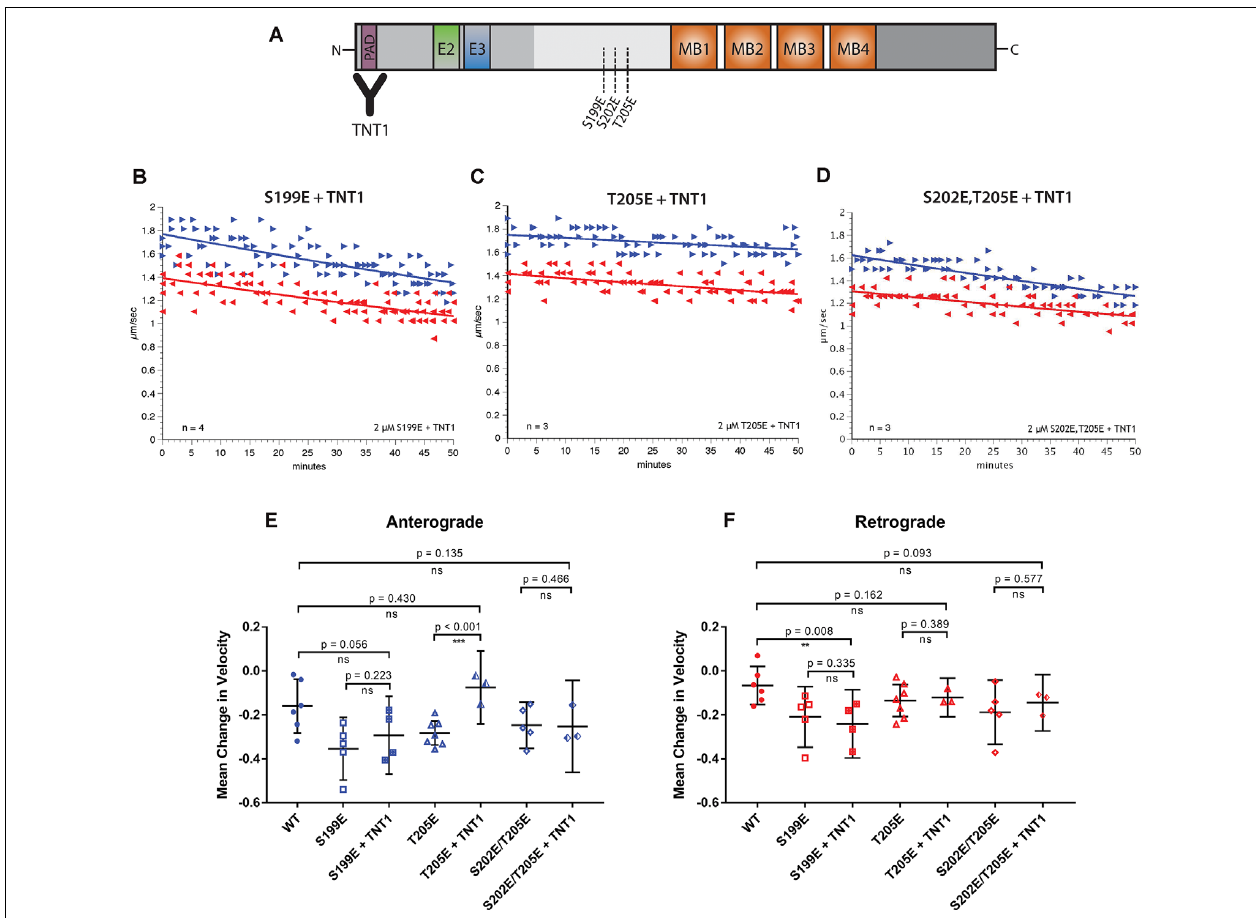
FIGURE 3 | Specific inhibition of anterograde FAT can be blocked by incubation with a PAD antibody. (A) Pseudophosphorylated tau monomers were incubated with TNT1 antibody which specifically binds the PAD (Kanaan et al., 2011) for 1 h before perfusion into the isolated squid axoplasm. (B) Even after incubation of hTau40-S199E with TNT1 FAT was still inhibited in both directions. (C) Incubation of TNT1 with hTau40-T205E prevented the specific inhibition of anterograde FAT. (D) Co-perfusion of TNT1 with hTau40-S202E/T205E did not prevent inhibition of FAT. (E) Quantitative analysis of anterograde FAT revealed no significant difference between hTau40-S199E perfused with ( n = 4) or without ( n = 5) incubation with TNT1 ( p = 0.223). By contrast, hTau40-T205E + TNT1 ( n = 3) was comparable to hTau40-WT ( n = 5; p = 0.430) and was significantly different to hTau40-T205E without TNT1 ( n = 7; p < 0.001). There was no significant difference between hTau40-S202E/T205E alone ( n = 5) or hTau40-S202E/T205E + TNT1 ( n = 4; p = 0.466). (F) hTau40-S199E + TNT1 ( n = 3) still significantly inhibited retrograde FAT compared to hTau40-WT ( n = 5; p = 0.008). hTau40-T205E ( n = 7) did not inhibit retrograde FAT and there was no change with TNT1 ( n = 3; p = 0.389). hTau40-S202E/T205E + TNT1 ( n = 3) was not significantly different from hTau40-S202E/T205E alone ( n = 4; p = 0.577). All scatter plots are presented as mean ± 95% confidence